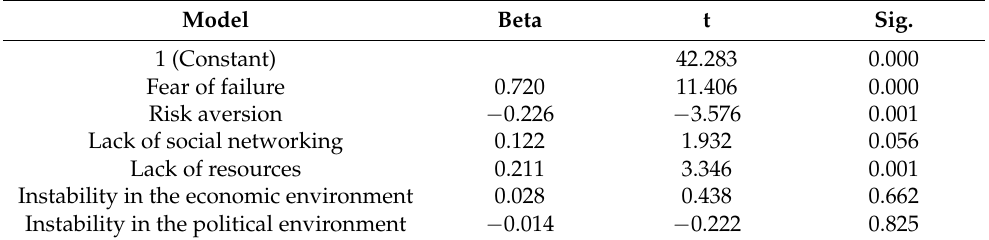
Table 3. Hypothesis